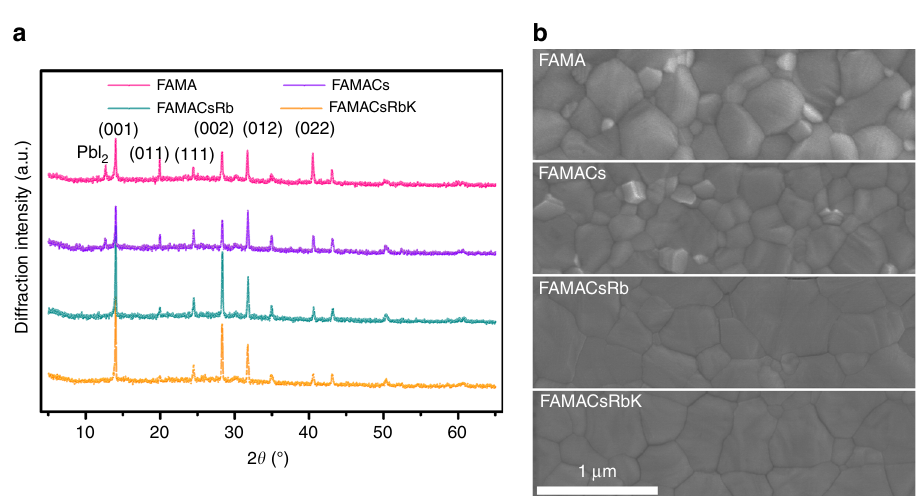
Fig. 1 One-dimensional XRD and SEM image. a XRD pattern and b SEM images for perovskite fi lms with cation cascade doping labeled as FAMA, FAMACs, FAMACsRb, and